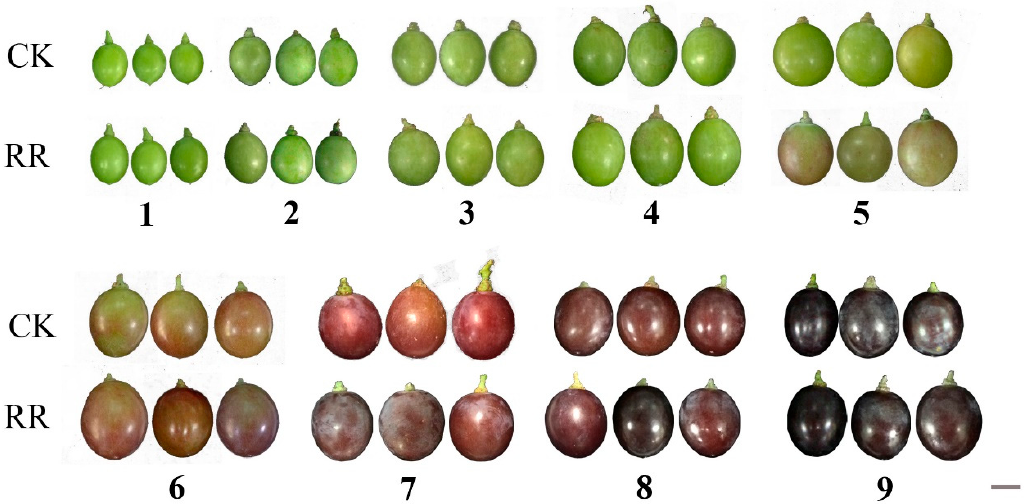
Figure 1. Morphological features of grape fruit development stages. Harvested fruit at different developmental stages from 21 days after pollination. RR: Root restriction, CK: control group. 1–9 indicate that the sample collection time is 6 June, 14 June, 22 June, 4 July, 14 July, 18 July, 23 July, 1 August, and 9 August 2017, respectively. Scale bar: 1 cm.